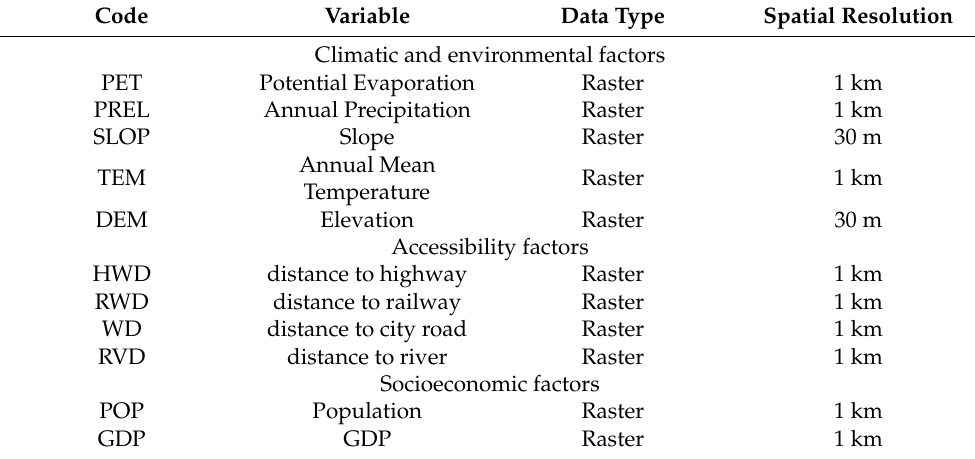
Table 1. Driver Indicators.